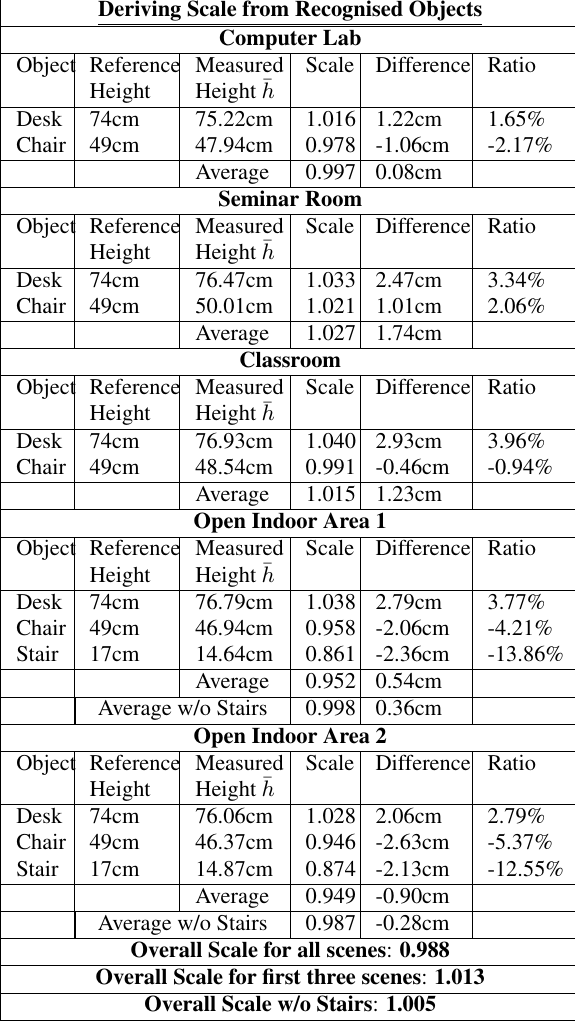
Table 2: Comparing measured and reference heights for identified objects per scene